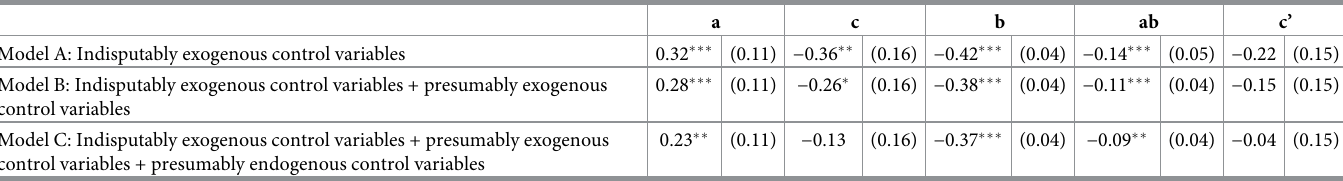
Model A: Indisputably exogenous control